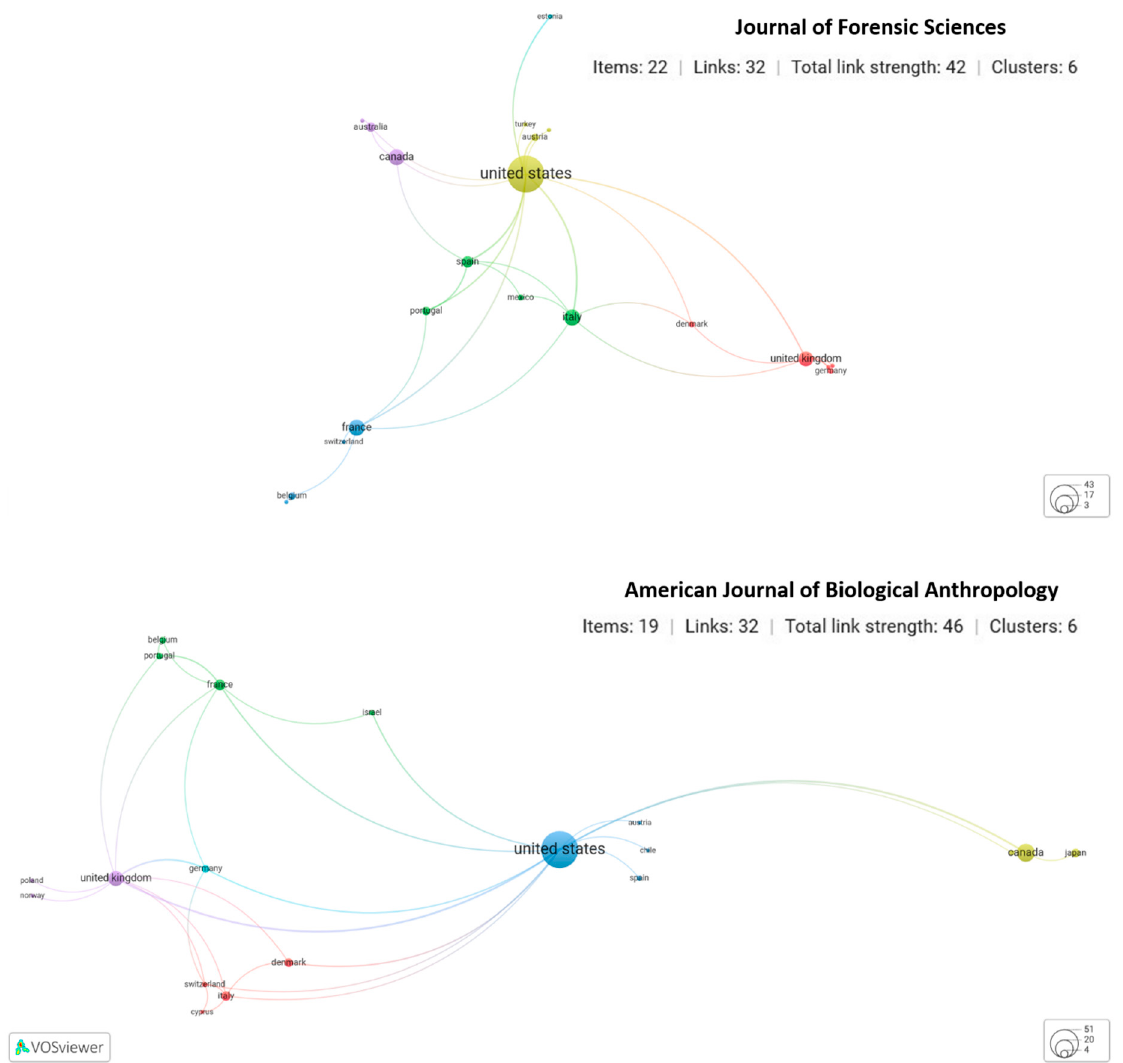
Figure 8. Network visualization of co-authorship by institutional countries for publications in the Journal of Forensic Sciences and the American Journal of Biological anthropology. The interactable maps are accessible at: Journal of Forensic Sciences https://app.vosviewer.com/?json=https://drive.google.com/uc?id=1v0tbG8dZP4-bXM5GMTIugKEH9FB9hzMh; American Journal of Biological Anthropology https://app.vosviewer.com/?json=https://drive.google.com/uc?id=1FLvcCMZYKpb0GZgxcG8HQ9jU0RjNeyI9 (Accessed on 16 January 2023).